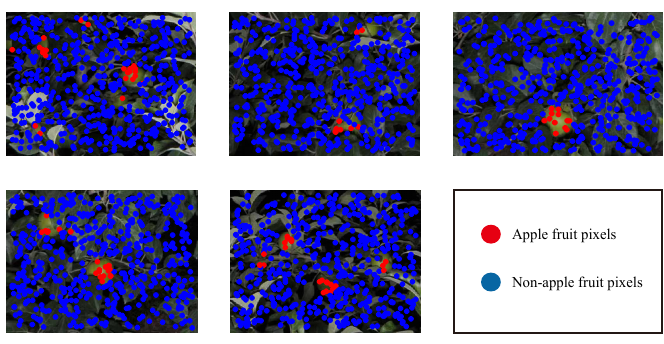
Figure 2. Sample points on images.